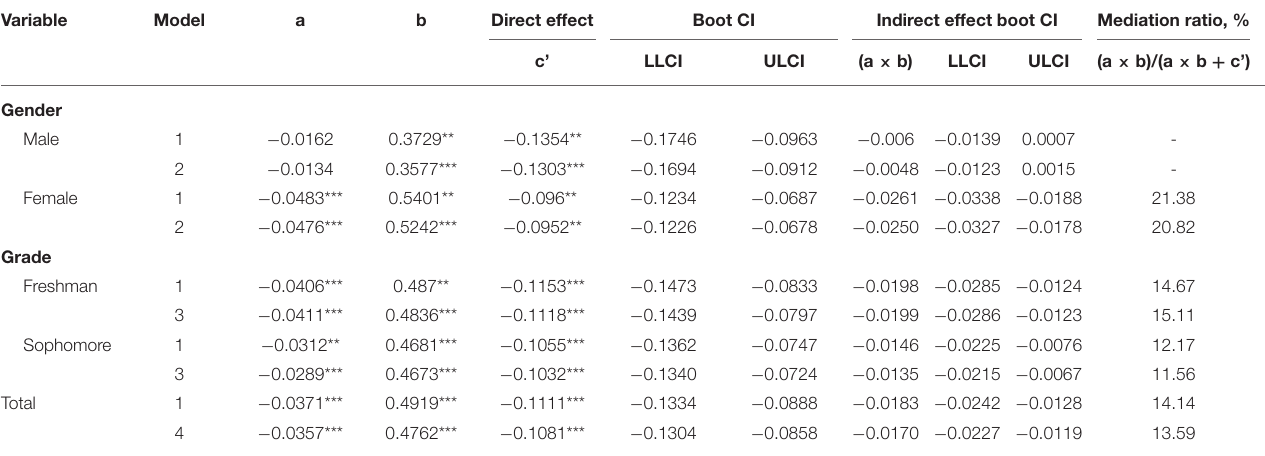
TABLE 4 | Mediating effect of sleep disorder between MHL and depressive symptoms.